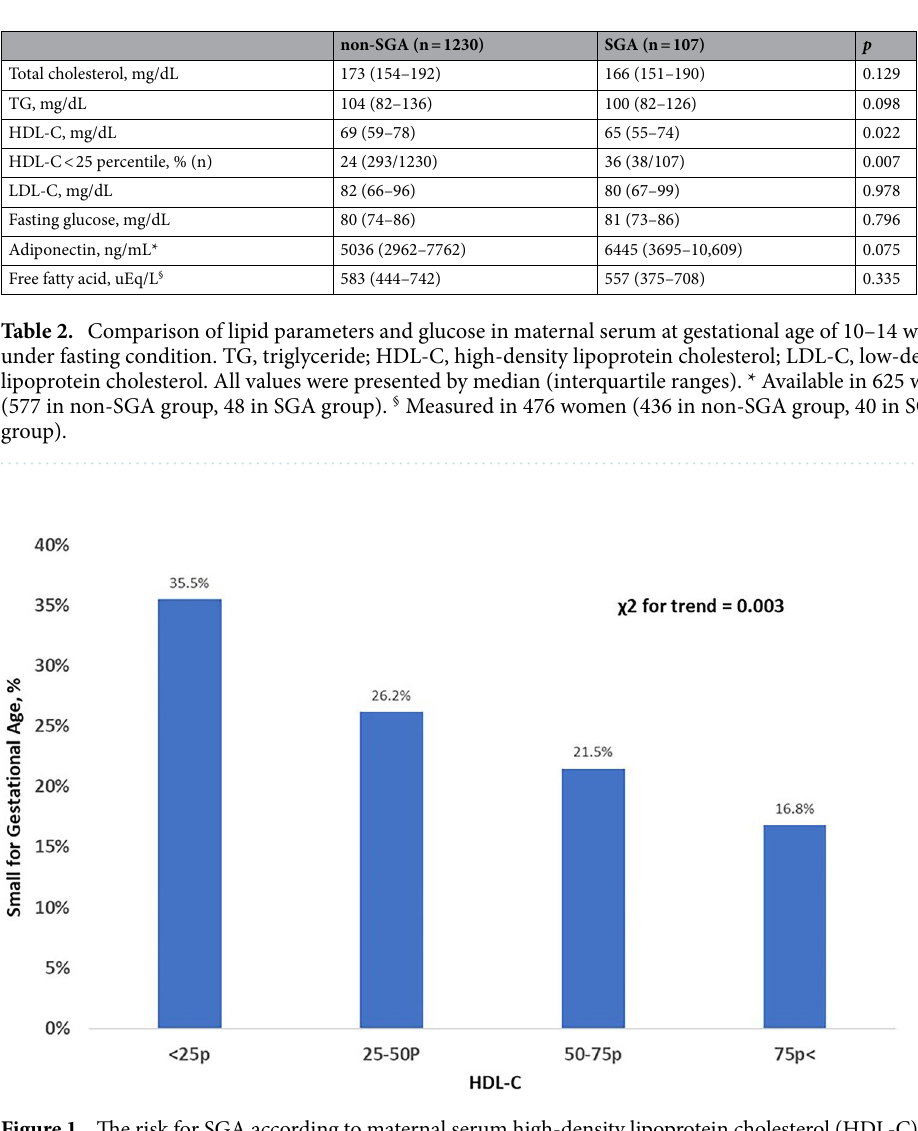
Figure 1. The risk for SGA according to maternal serum high-density lipoprotein cholesterol (HDL-C) quartiles at 10–14 weeks of gestational